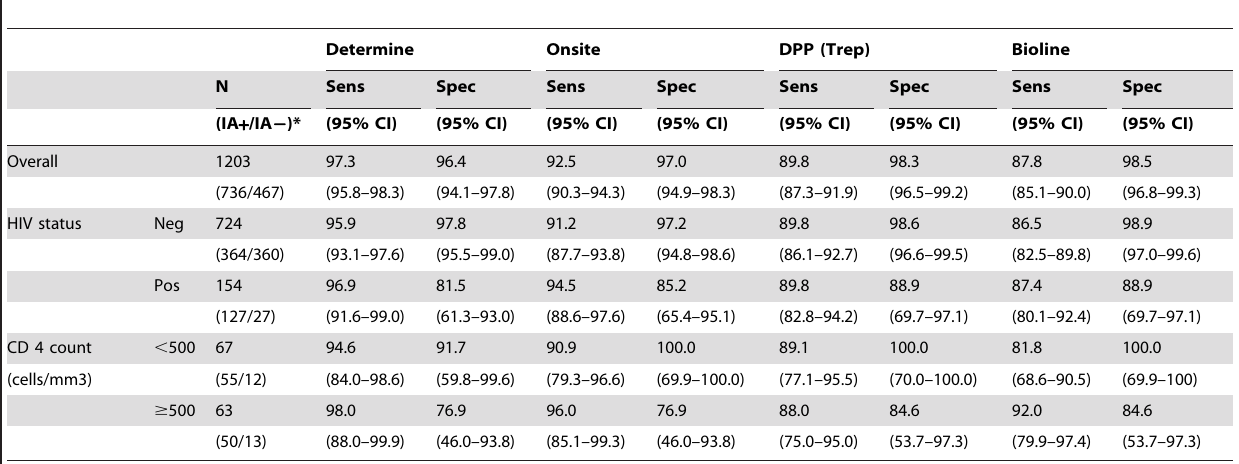
Table 3. Syphilis POC test sensitivity and specificity (compared to reference Treponemal immunoassay), overall and by HIV status and CD4 cell count.